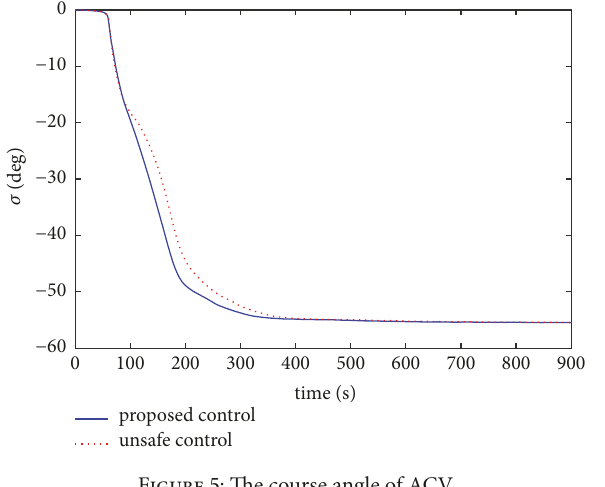
Figure 8: The variation of 𝑇𝑅